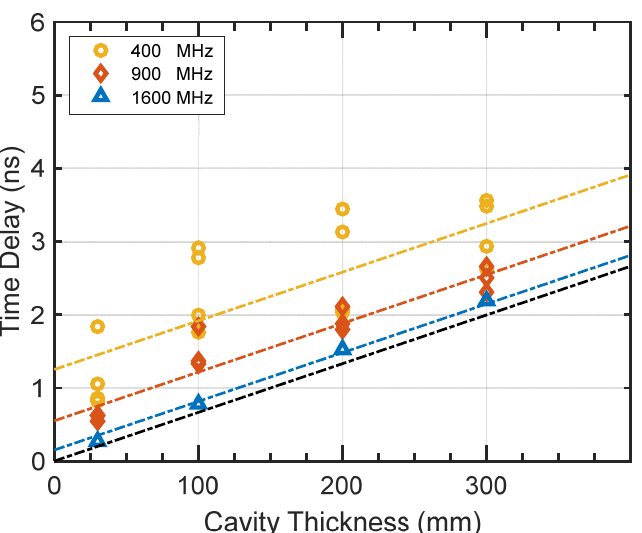
Figure 12. Relationship between apparent time delay, Δ𝑡̅, of combined GPR reflection waves of the top and bottom of air-cavities (or time delay, Δ𝑡̅ = t 3 − t 1 ) and the thickness of air-cavities, H cavity . Three color dashed lines represent the theoretical relationship between apparent delay time and cavity thickness (yellow, red, and blue for 400 MHz, 900 MHz, and 1600 MHz GPR signals, respectively). A black dashed line represents the theoretical relationship between true delay time and cavity thickness.